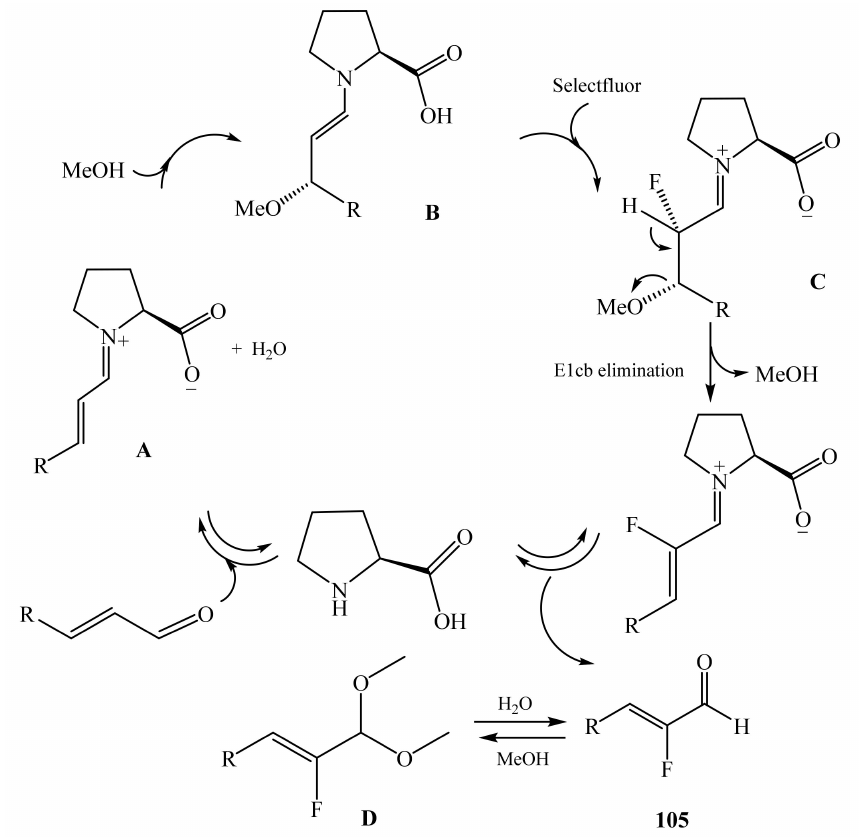
Scheme 44. Possible mechanism of the cascade reaction of asymmetric methoxyfluorination-